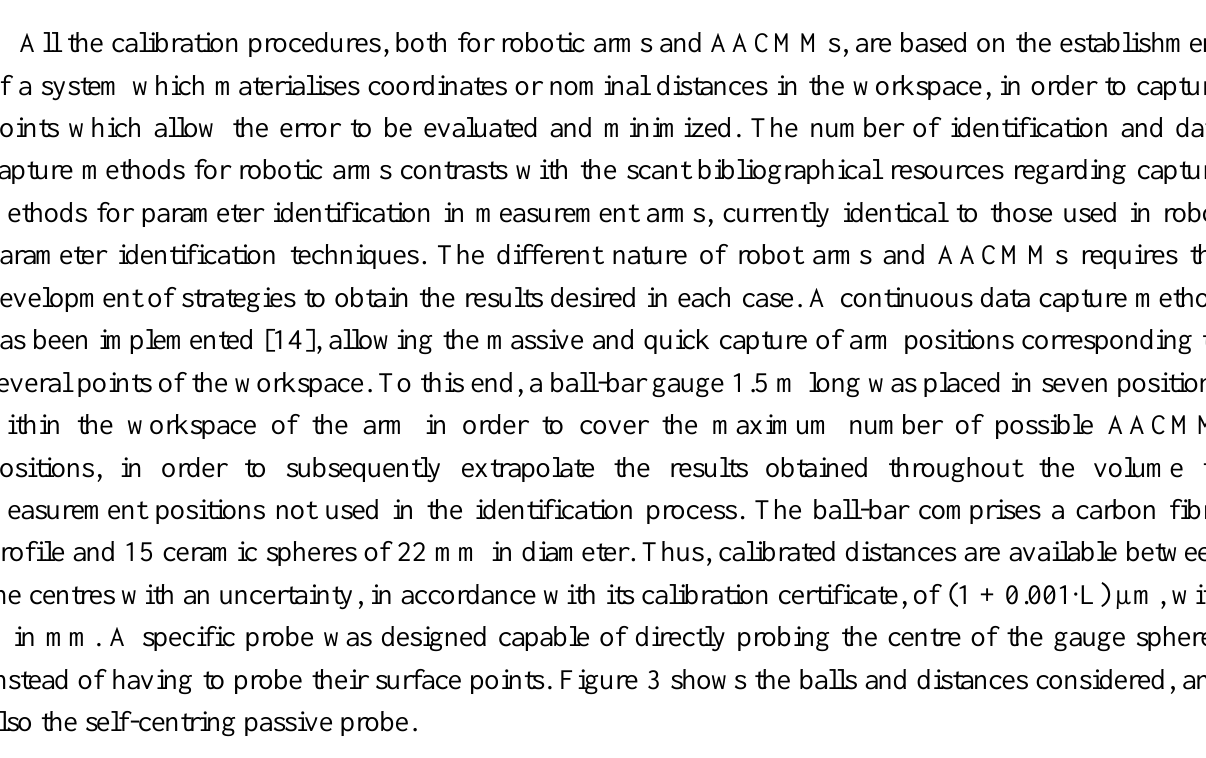
Figure 3. Balls measured and distances between sphere centres calculated